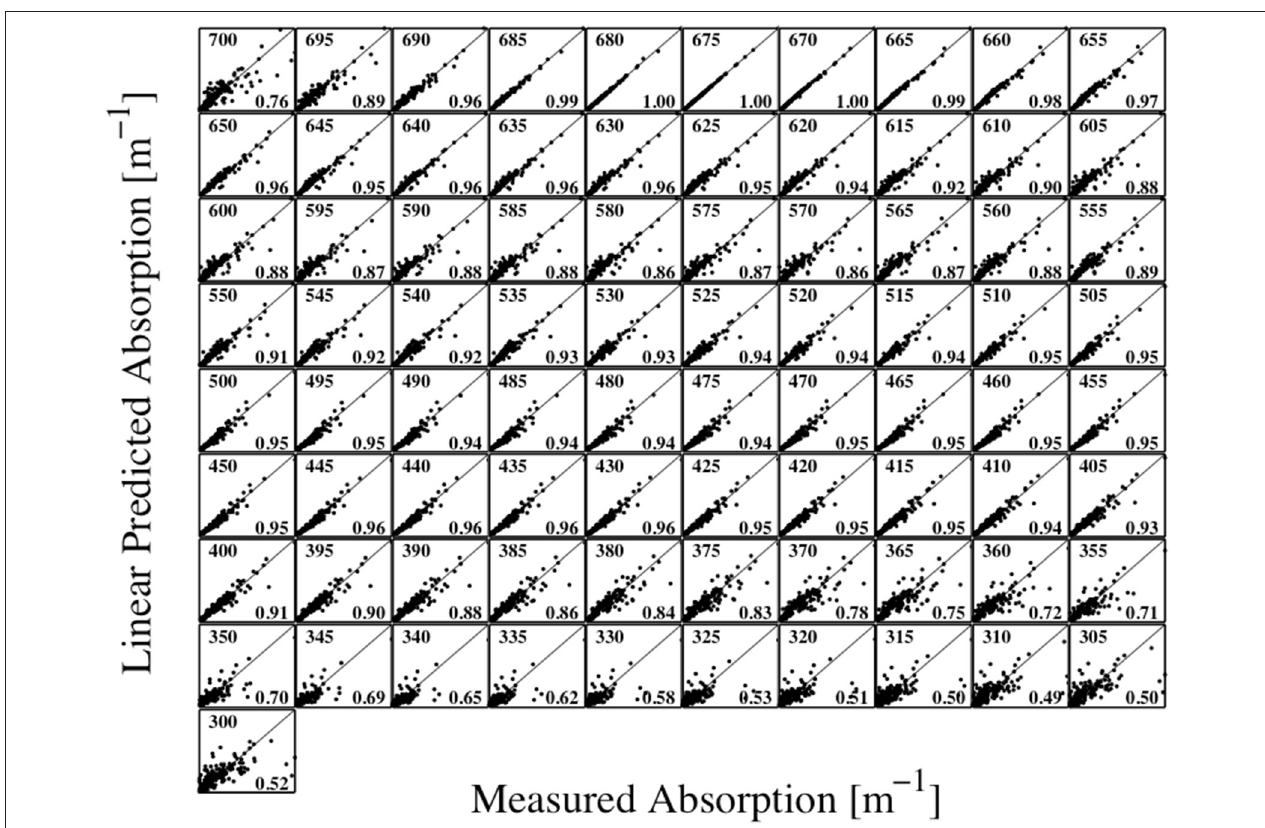
FIGURE 4 | Measured total absorption (m − 1 ) normalized to 675 nm (horizontal axis) versus the predicted total absorption (m − 1 ) (vertical axis) using the multiple linear regression of Chl HPLC and Chl HPLC 2